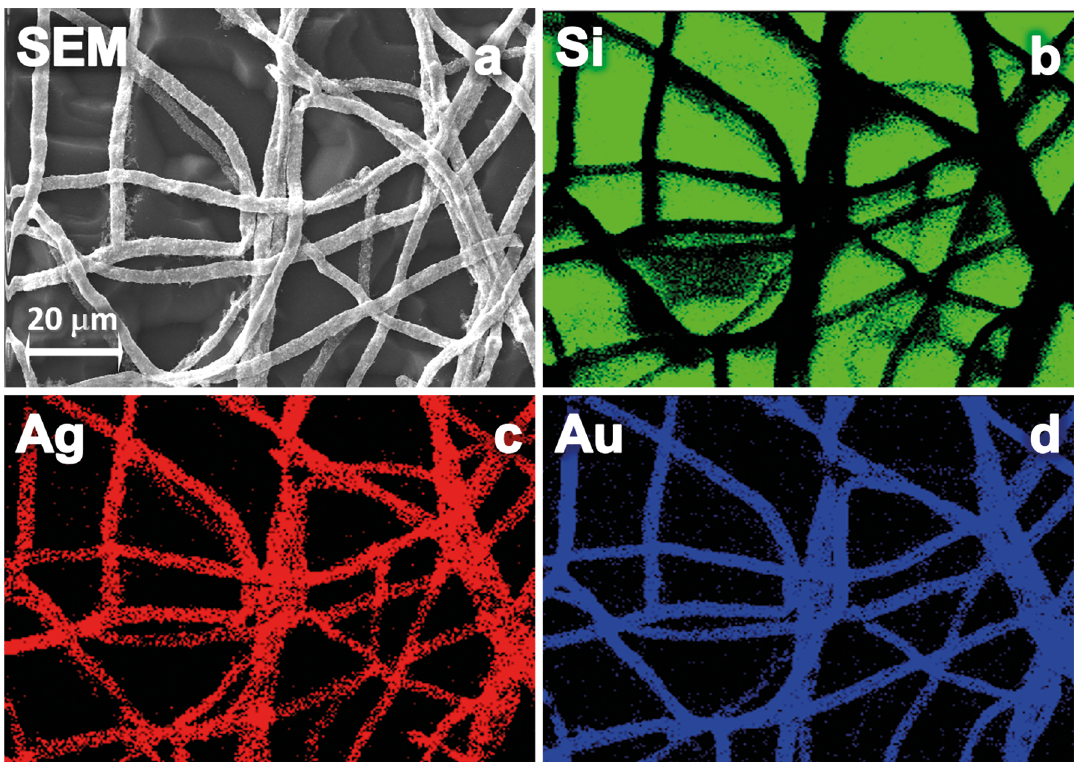
Figure 2. SEM images and EDX mapping in 2D of the elements (b) Si, (c) Ag and (d) Au that compose the intermediate segments of the hyphae filamentous fungus Aspergillus aculeatus covered with gold and silver nanoparticles. Hyphae was deposited on a silicon